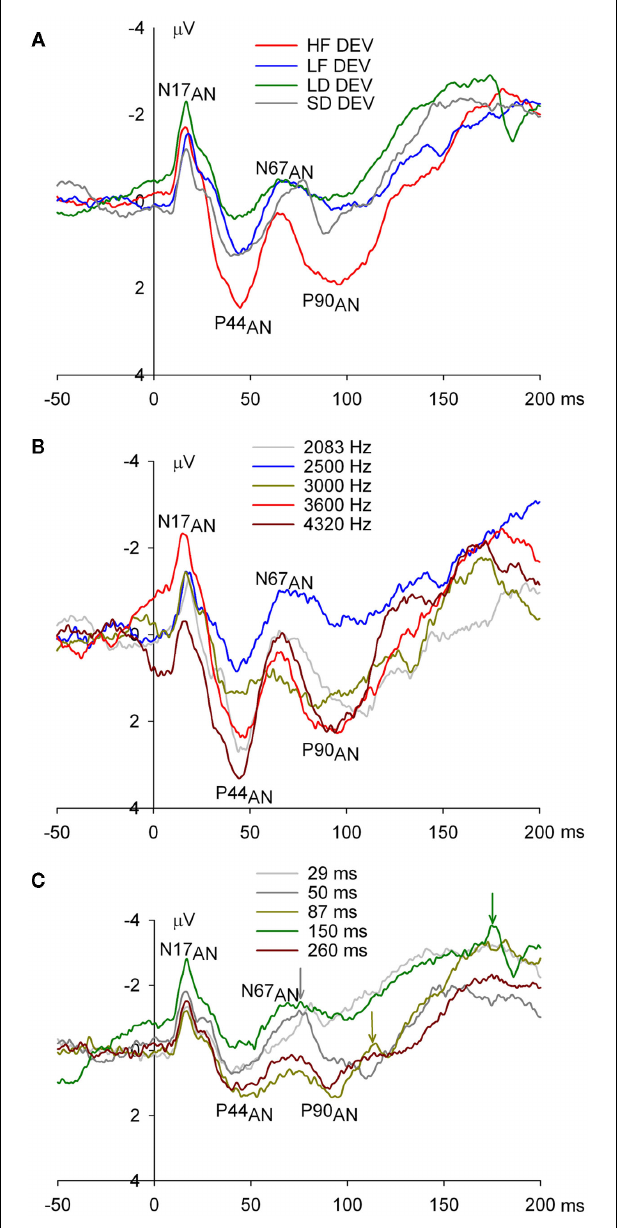
FIGURE 3 | Epidural recorded ERPs in the anesthetized rat during oddball and many-standards control sequences. (A) ERPs to each of the four key stimuli of high frequency (HF), low frequency (LF), long duration (LD), and short duration (SD), averaged over oddball sequences showing four exogenous peaks N17 AN , P44 AN , N67 AN , and P90 AN .The morphology of anesthetized rat ERPs was different to those of the awake rat, component amplitudes overall under anesthesia were reduced (note the different gains for Figure 2 and in this figure), and the peak latency of the earliest negative peak occurred earlier (17 vs. 29ms). (B) ERPs to the range of frequencies used in the many-standards frequency control sequence showing little systematic difference as a function of frequency. (C) ERPs to the range of durations used in the many-standards duration control sequence showing evidence of offset potentials consisting of negative and positive peaks approximately 28 (marked with arrows) and 36ms after the offset of 50, 87, and 150ms duration